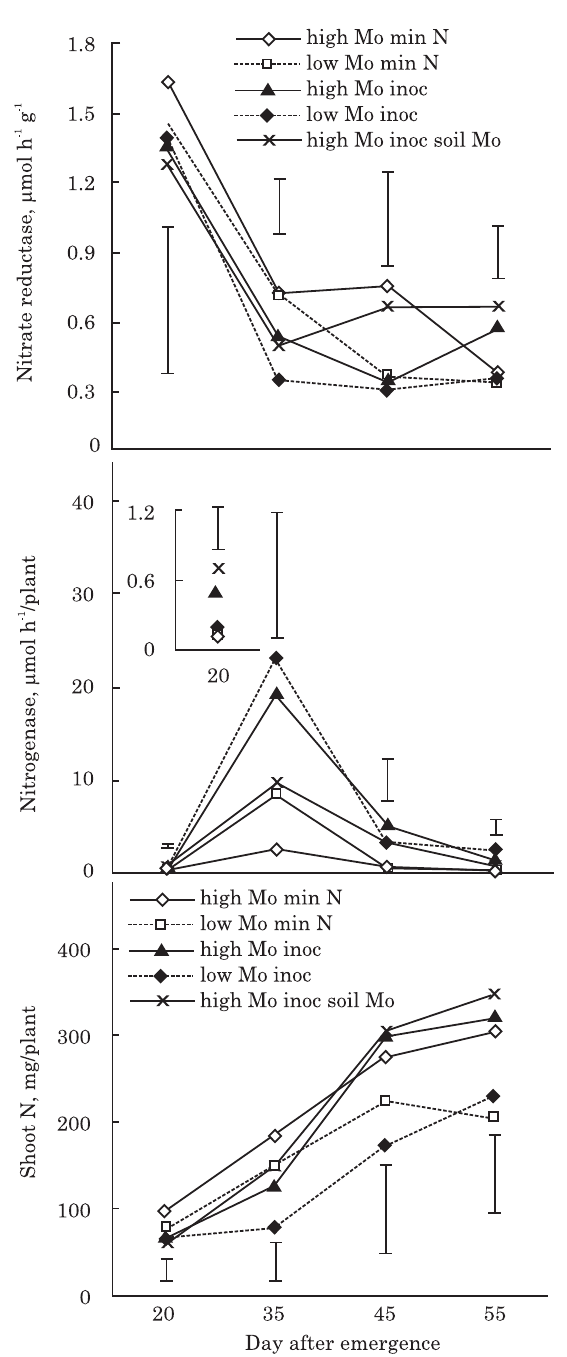
Figure 2. Nitrate reductase activity in leaves, nitrogenase activity in root systems, and N accumulated in shoots, of common bean plants originating from seeds with low or high Mo concentration grown at two N sources (inoculated with rhizobia or mineral N) or with additional Mo applied to the soil, at four growth stages (Experiment 1); inset displays values of 20 DAE. Vertical bars represent the least significant difference by Tukey’s test at 0.05 probability and compare treatments on each evaluation